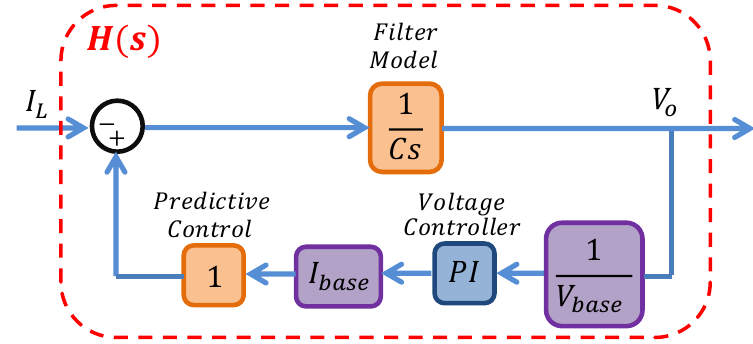
Figure 5. Disturbance-rejection linear model.